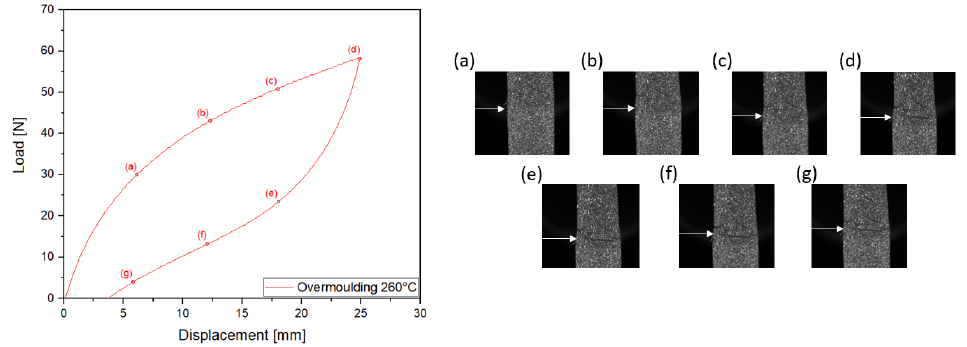
Figure 8. Cyclic loading 25 mm of specimens overmoulded at 260 ◦ C. Images ( a – g ) show a close-up view of the interface at different displacements during the test. TPV1 is at the bottom and TPV2 at the top. Necking can be seen for TPV1 in image ( e ).